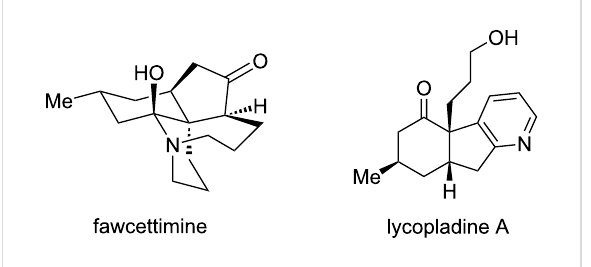
Figure 2: Examples of Lycopodium alkaloids synthesized from 3a-substituted